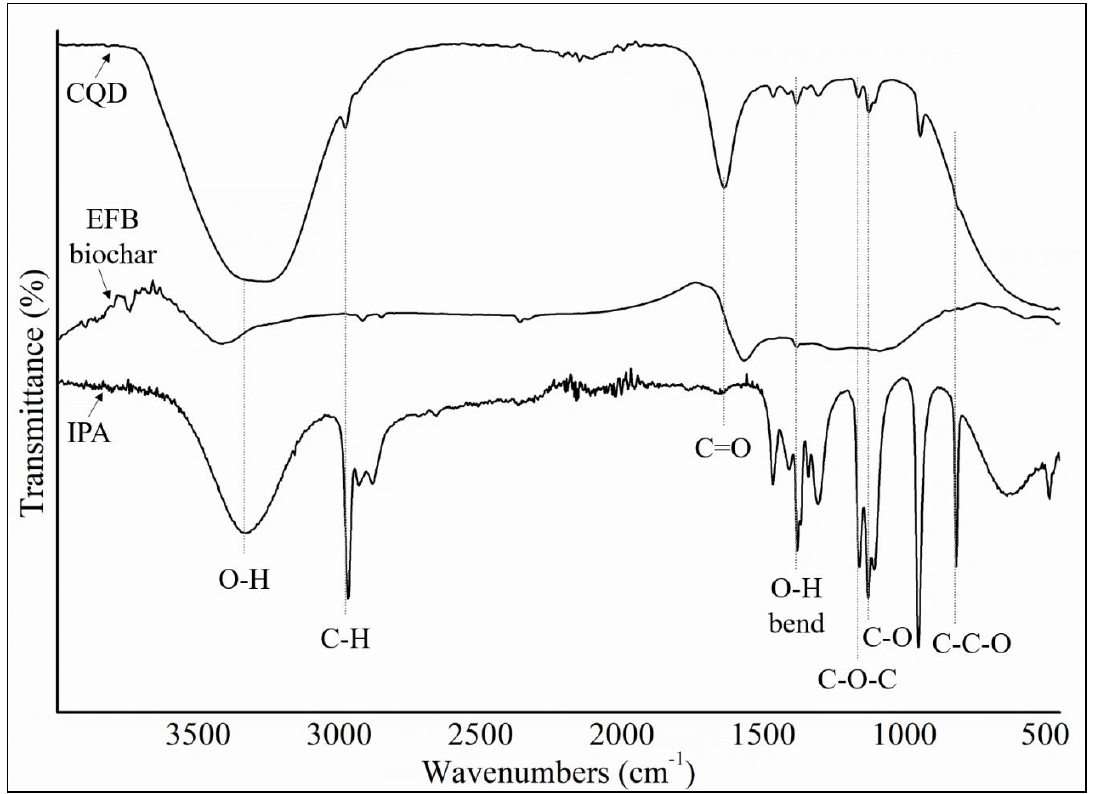
Figure 4. Comparison of isopropanol (IPA), EFB biochar and CQD Fourier transform infrared (FTIR) spectra .